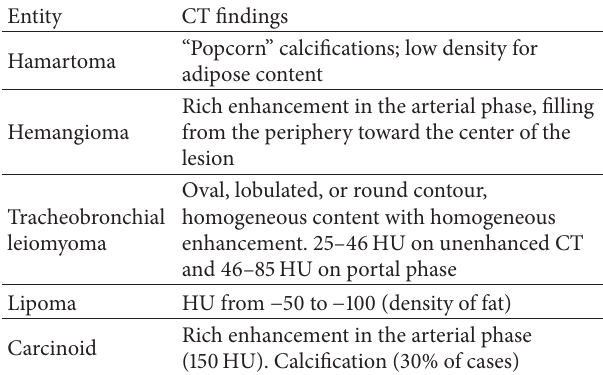
Table 2: Differential diagnosis table for granular cell tumor of trachea. Entity CT findings “Popcorn” calcifications; low density for Hamartoma adipose content Rich enhancement in the arterial phase, filling Hemangioma from the periphery toward the center of the lesion Oval, lobulated, or round contour, Tracheobronchial homogeneous content with homogeneous leiomyoma enhancement. 25–46 HU on unenhanced CT and 46–85 HU on portal phase Lipoma HU from − 50 to − 100 (density of fat) Rich enhancement in the arterial Carcinoid